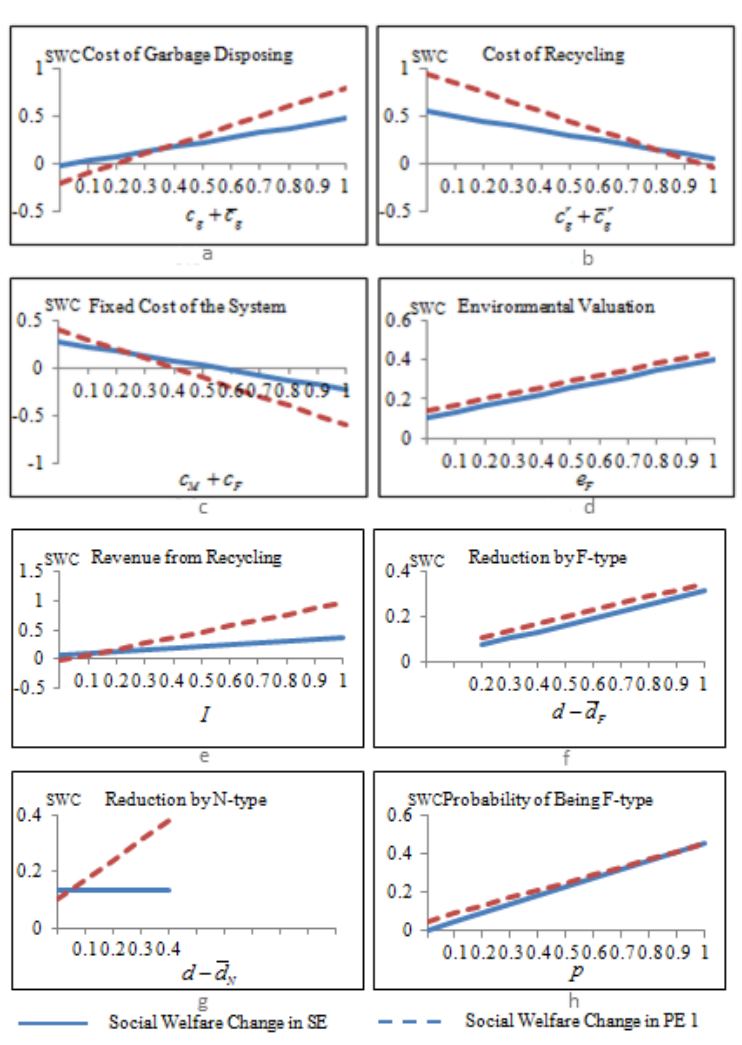
Figure 3. Social welfare